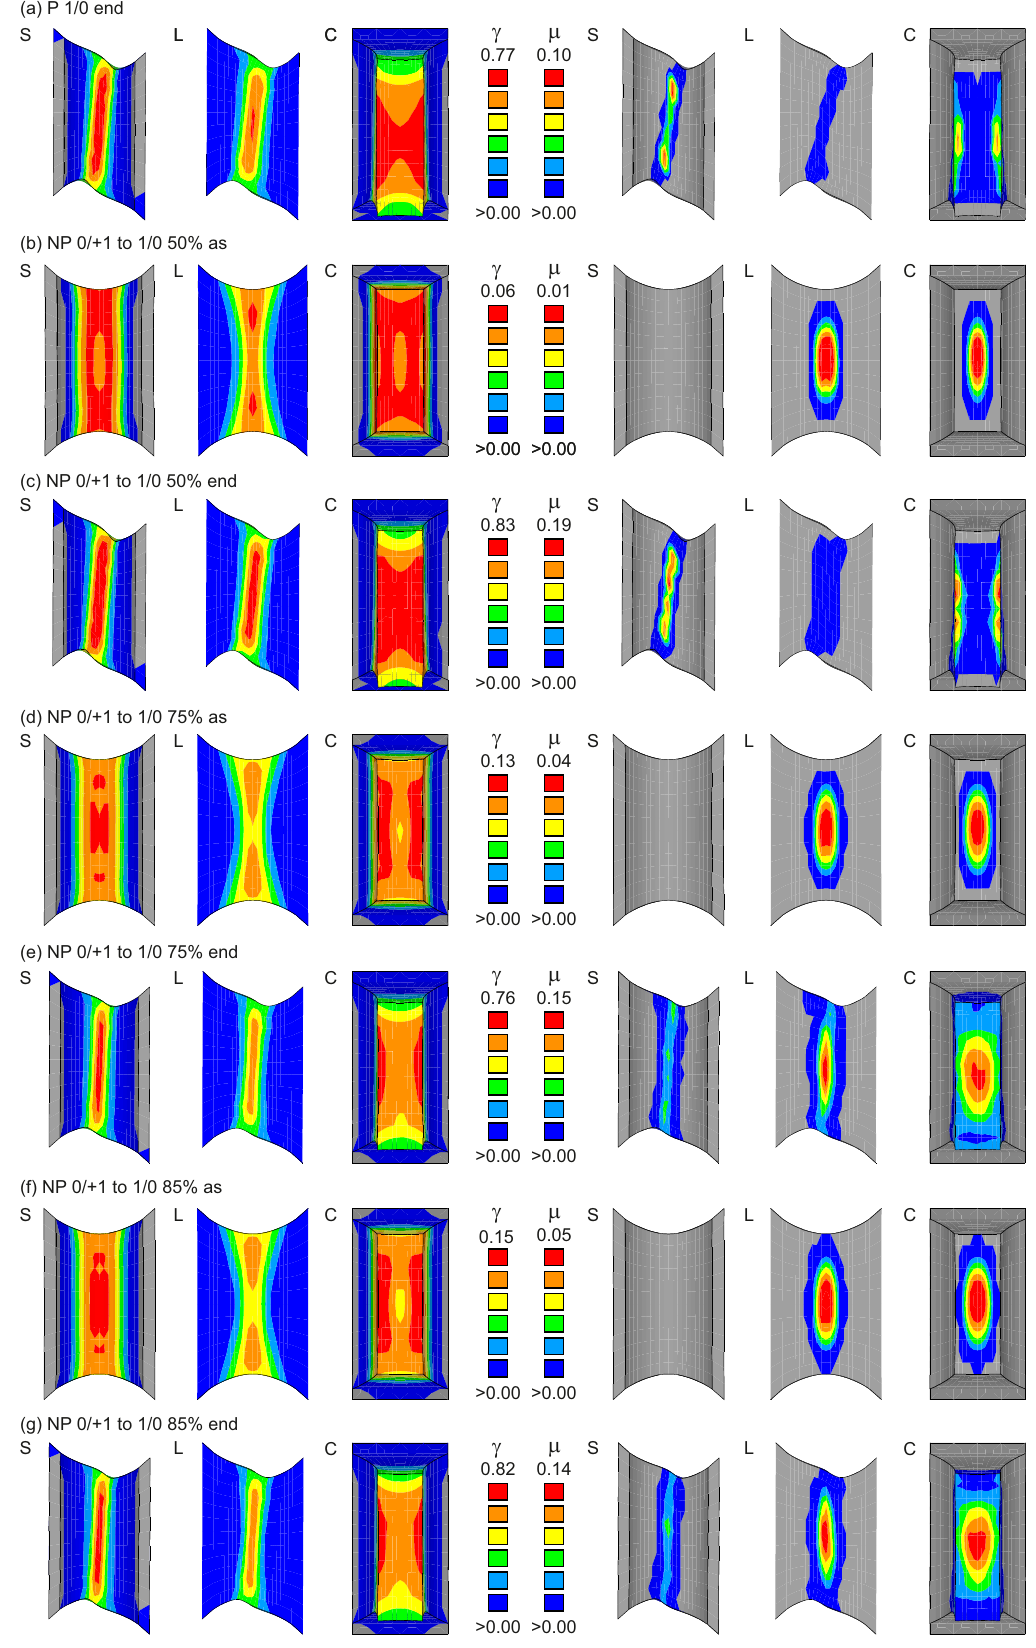
Figure 8. Equivalent plastic strain γ and equivalent damage strain µ : S—surface, L—longitudinal section, C—cross